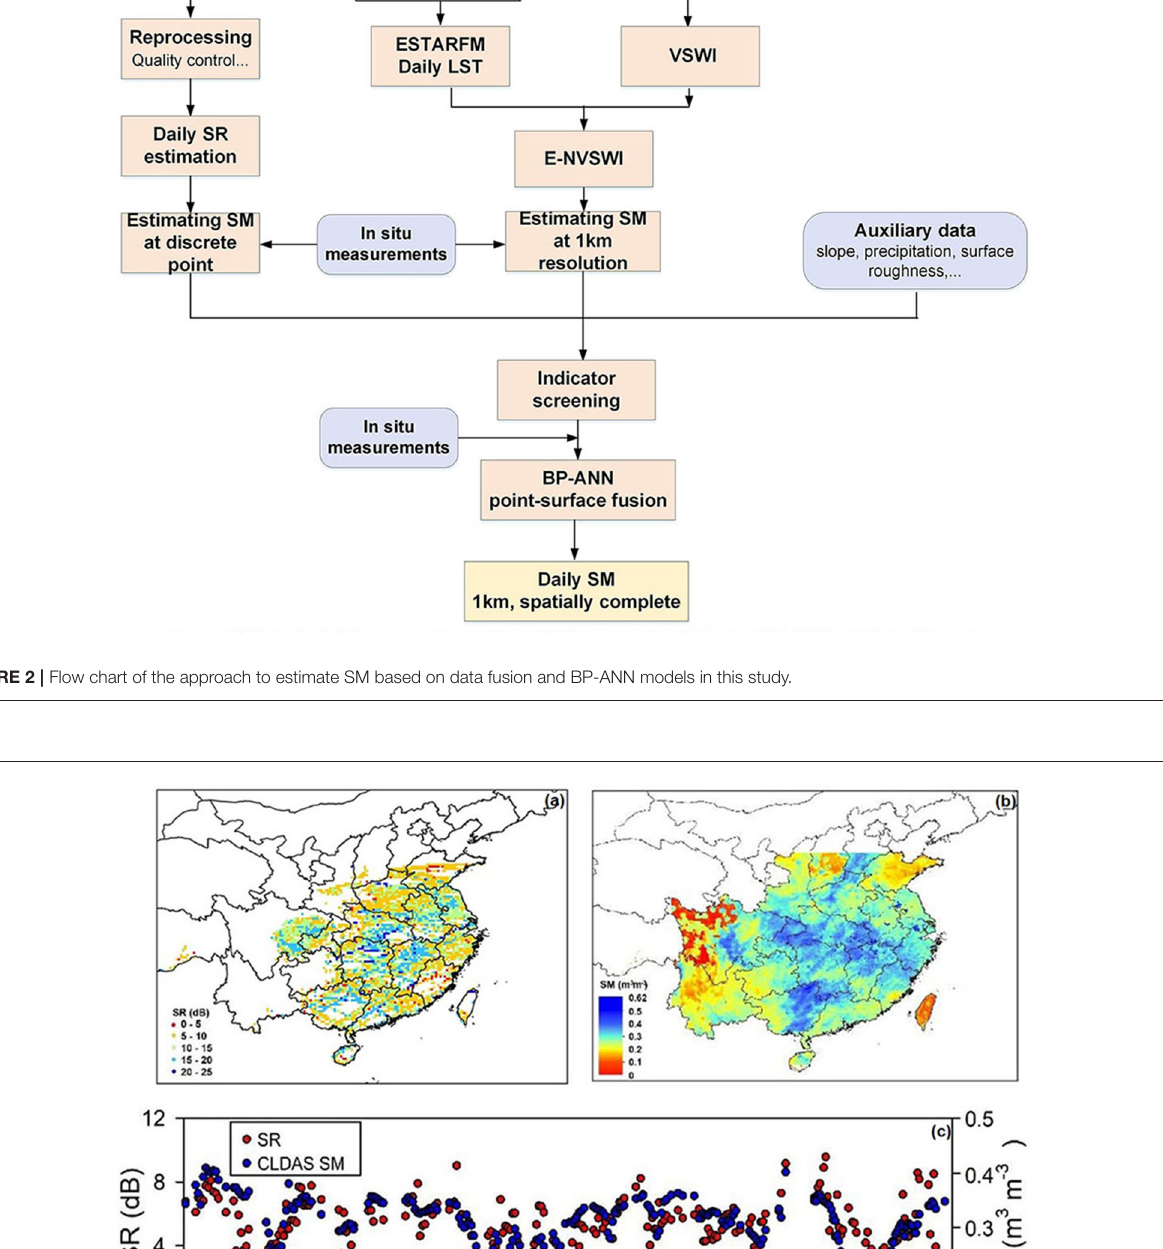
Frontiers in Big Data |